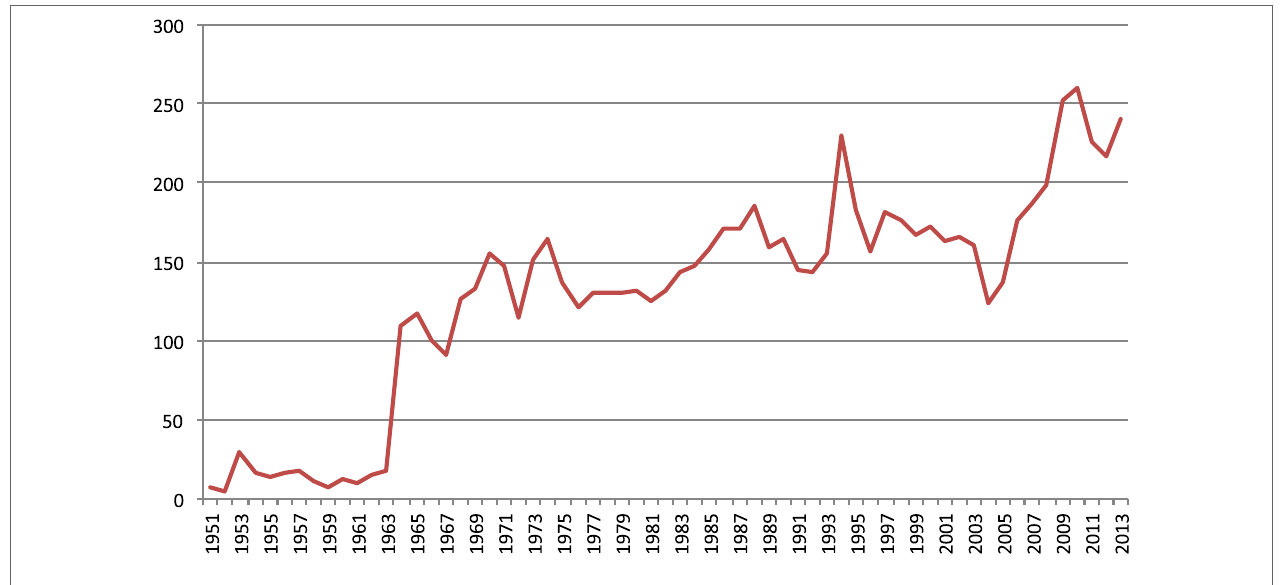
FigUre 2 | Evolution of the Physical Therapy production from 1951 to